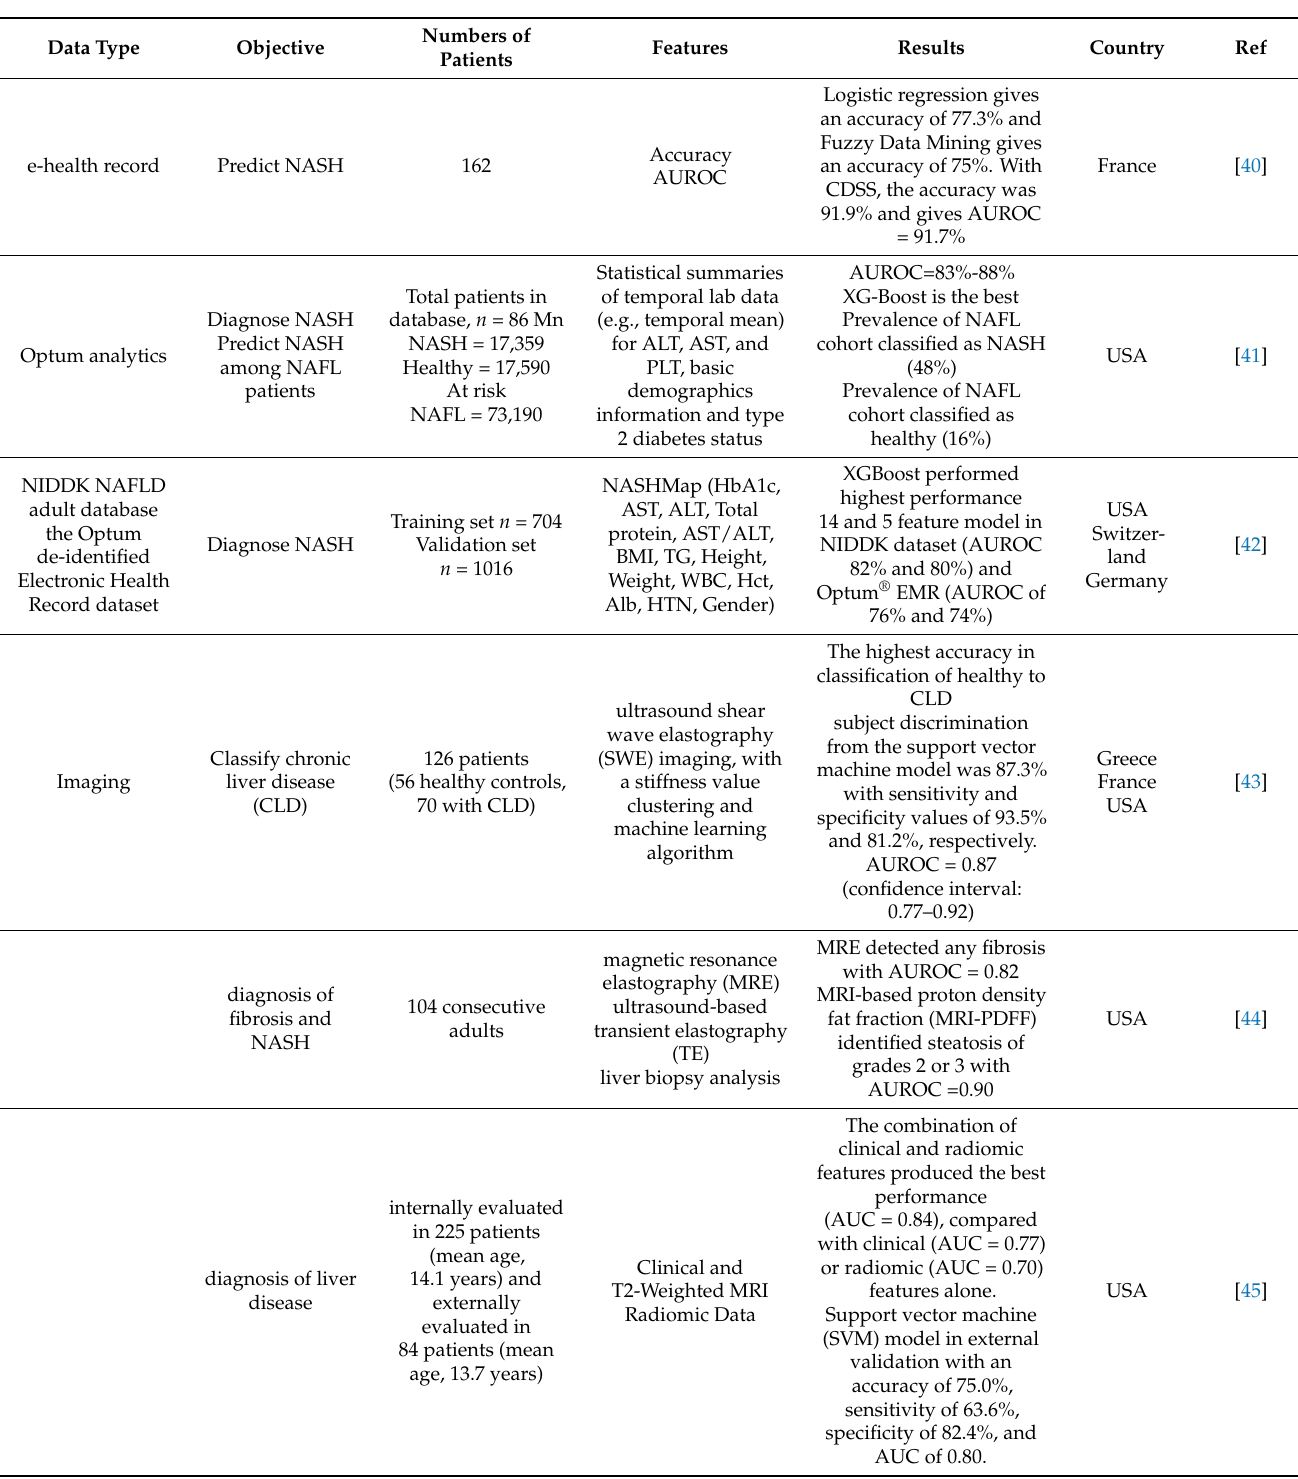
Table 1. The current application of AI in NAFLD and